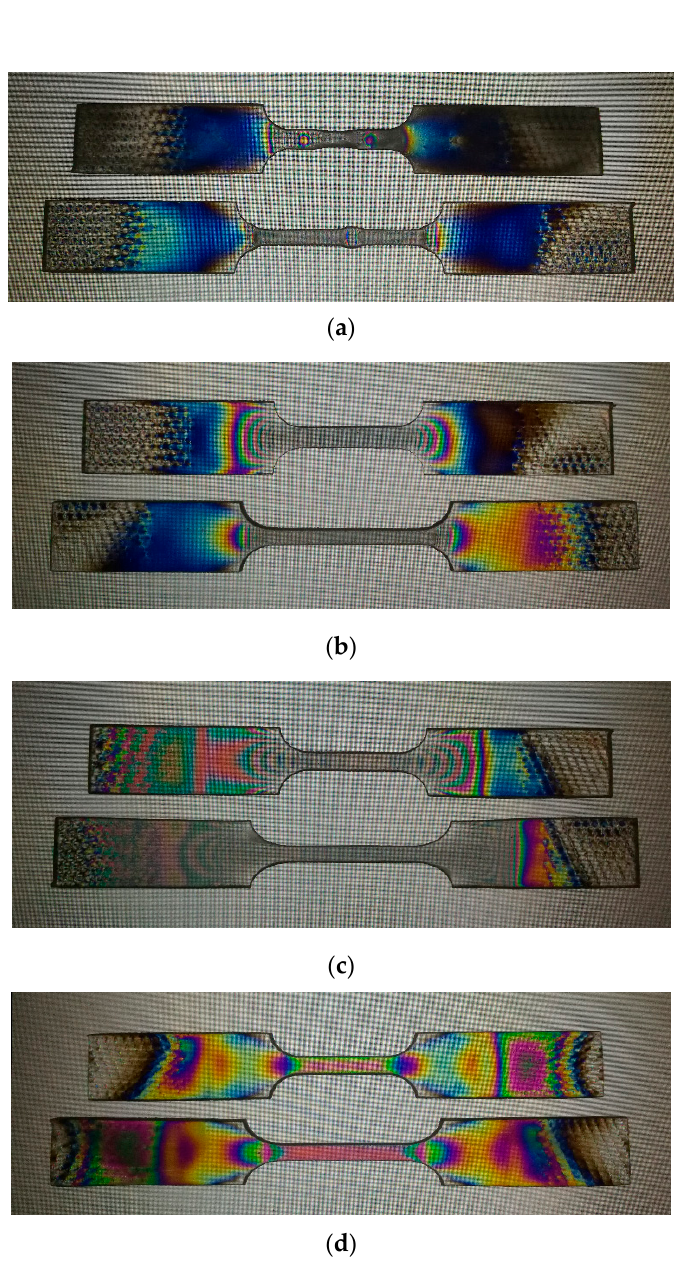
Figure 12. Images of the photo-elastic effect in samples programmed to two maximum programming strains of 30% ( top ) and 100% ( bottom ) at 128 °C ( a ); 135 °C ( b ); 145 °C ( c ) and 160 °C ( d ).